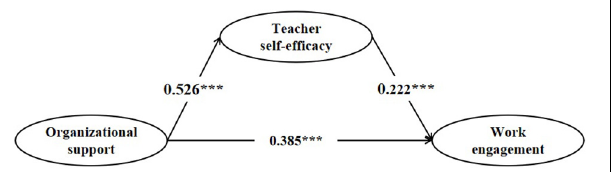
FIGURE 2 | Results of the research model (*** p < 0.001).